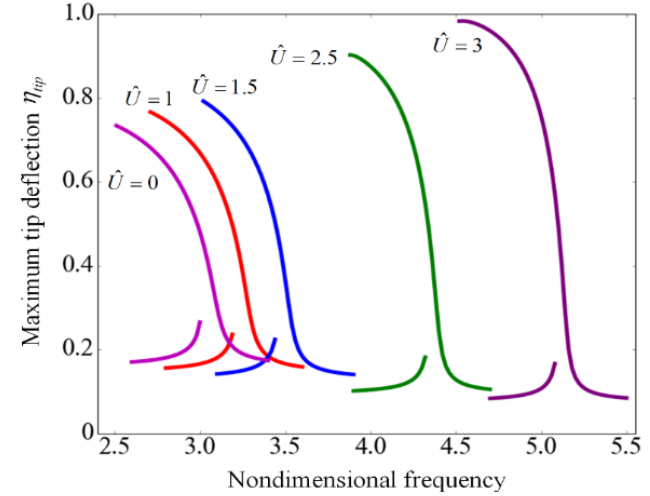
Figure 15. Frequency response curves of suspended microchannel resonators for different nondimensional velocities with β dc = 1 and β ac = 0.01